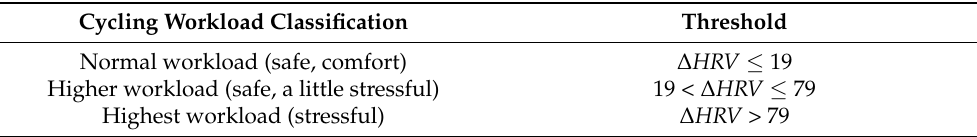
Table 6. CART classification thresholds.